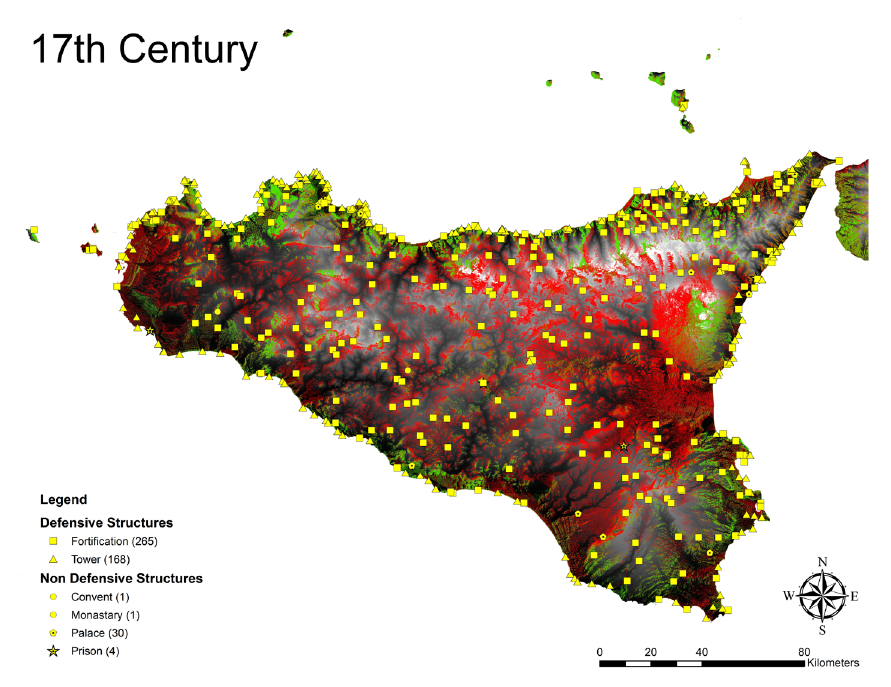
Figure 8. Figure showing the distribution of defensive structures and their viewsheds in the 17th century. Fortifications are represented by squares and the area they have surveillance over is in red whereas towers are represented by triangles and the area they have surveillance over is in green. Also included are church buildings represented by circles, palaces represented by hexagons, and prisons represented by a star. Image derived from an ASTER GDEM (a product of NASA and METI).